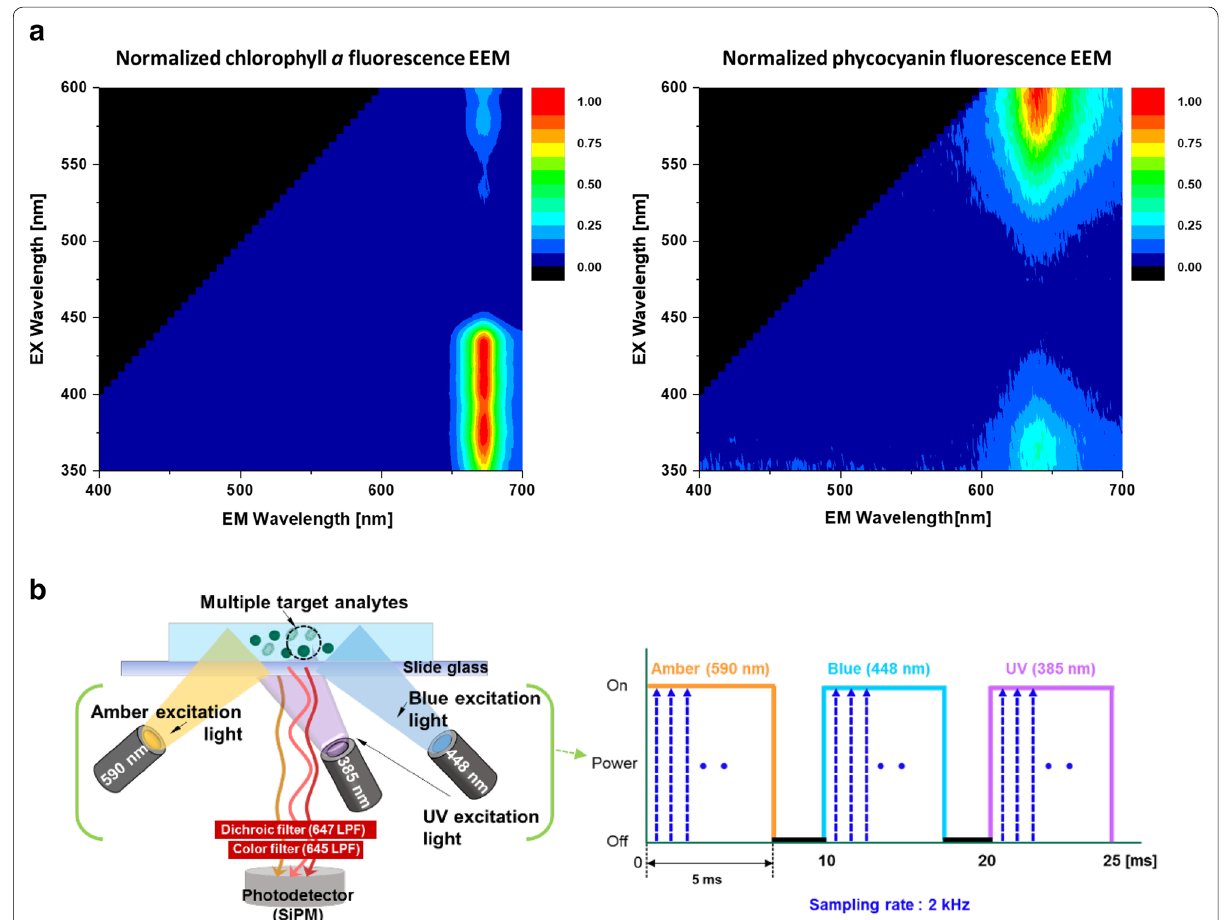
Fig. 1 Working principle of an LED based fluorescence detection: a normalized fluorescence excitation‑emission matrices (EEMs) of chlorophyll a and phycocyanin pigments and b a schematic of the concept of an LED based fluorescence sensor